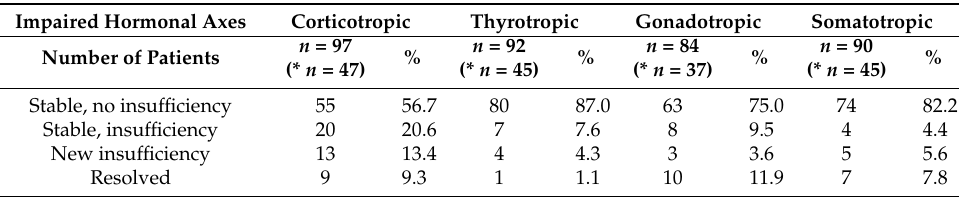
Table 2. Intraindividual changes in pituitary insufficiencies defined by the physicians’ diagnosis between the first visit and the